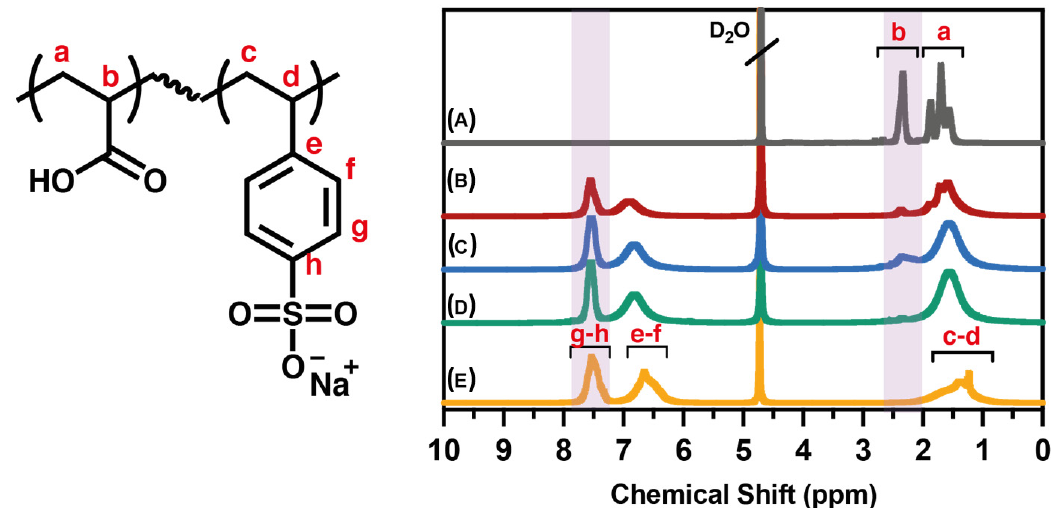
Figure 2. 1 H -NMR spectra of PAA and PSS homo- and P(AA- co -SS) copolymers. ( A ) PAA, ( B ) P(AA- co -SS) (70:30), ( C ) P(AA- co -SS) (50:50), ( D ) P(AA- co -SS) (30:70), ( E ) PSSNa. Deuterium oxide (D 2 O) was used as a deuterated solvent. Small letters of a, b, c, d, e, f, g and h assigned in the copolymer structure and 1 H-NMR spectra indicate aliphatic and aromatic P(AA- co -SS) protons.